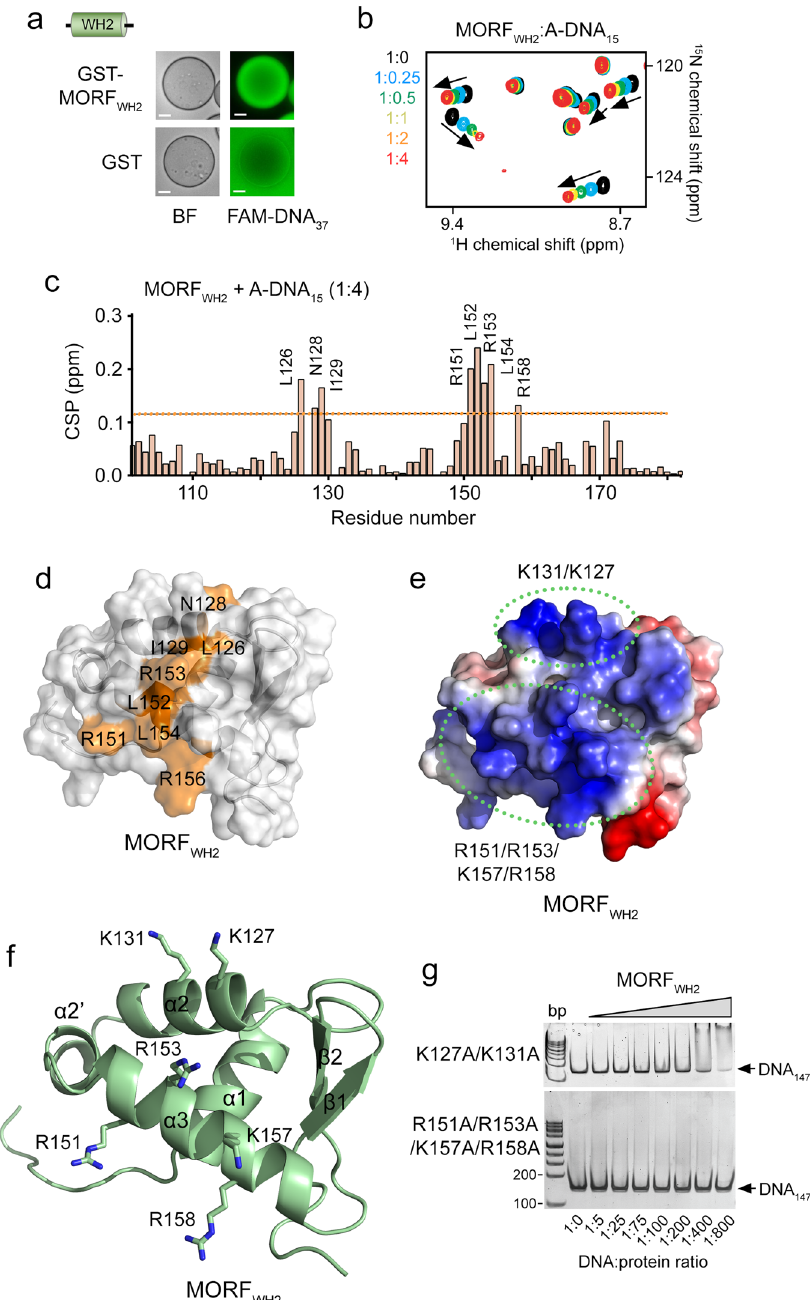
Fig. 2 | Structural basis for binding of MORFWH2 to DNA. a Confocal images of GST-MORF WH2 or GST (control) bound to glutathione Sepharose beads in the presence of FAM-labeled 37bp dsDNA. Scale bar, 20 µ m. b Overlay of 1 H, 15 N HSQC spectraofMORF WH2 inthepresenceofincreasingamountof15bpA-richdsDNA(A- DNA 15 ). Spectra are color coded according to the protein:DNA molar ratio. c Histogram of normalized CSPs in 1 H, 15 N HSQC spectra of MORF WH2 induced by a fourfold molar excess of A-DNA 15 as a function of residue. d – f The solution NMR structure of MORF WH2 . Residues of MORF WH2 that exhibited large CSPs upon additionofA-DNA 15 (greaterthanaverageplusonestandarddeviation,indicatedby thedotted linein c )aremappedonthestructure of MORF WH2 ,coloredorangeand